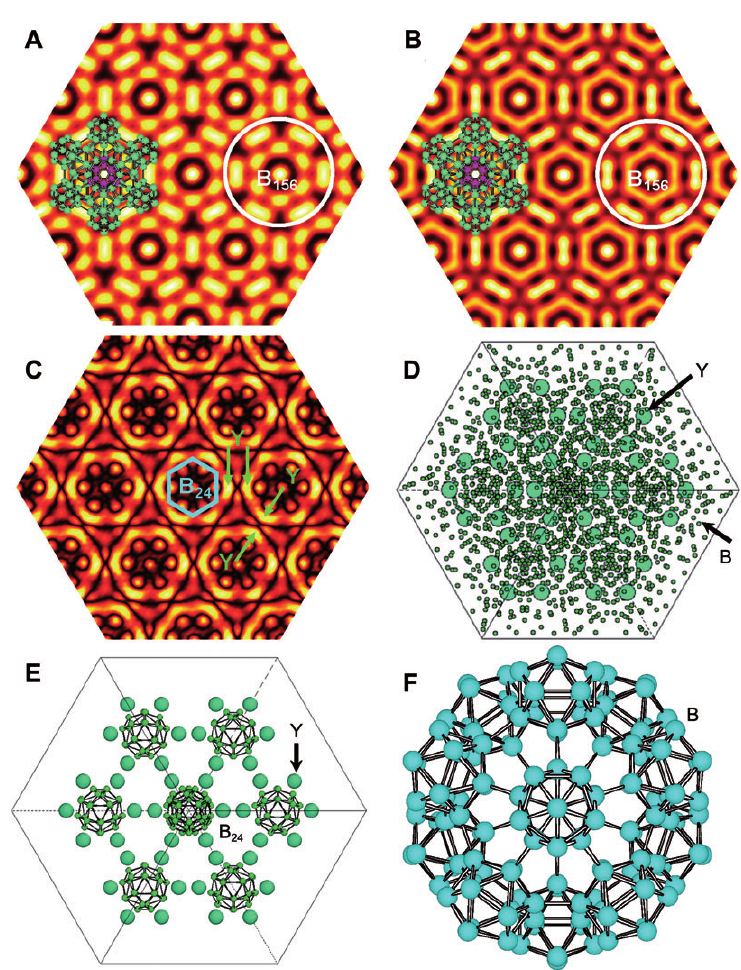
Figure 10 (A) Observed HREM image, (B) simulated image, and (C) difference image of (A) and (B). Structure models of (D) YB clusters (Y-holes with non-icosahedral B Y-B 24 clusters projected along the 5-fold axis.